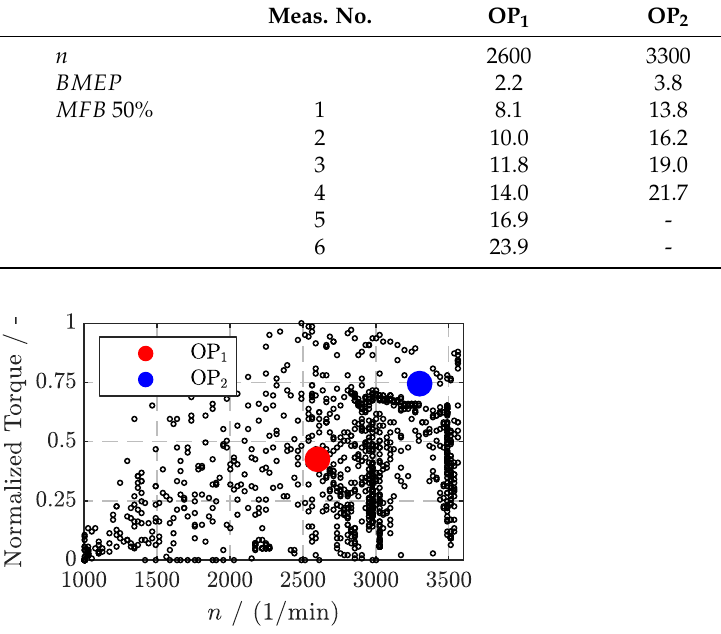
Figure 3. Location of the investigated operating points in Non-Road Transient